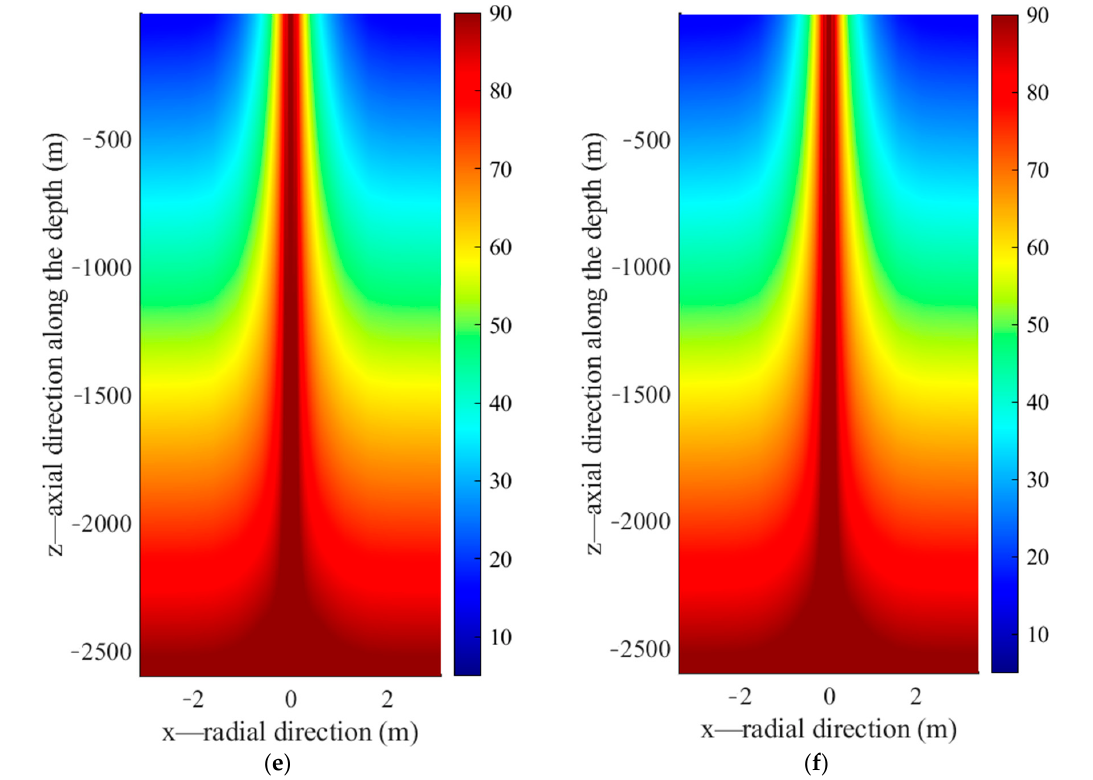
Figure 15. Rock temperature evolution underground during 30 days of high temperature heat storage: ( a ) 5 day; ( b ) 10 day; ( c ) 15 day; ( d ) 20 day; ( e ) 25 day; ( f ) 30 day.